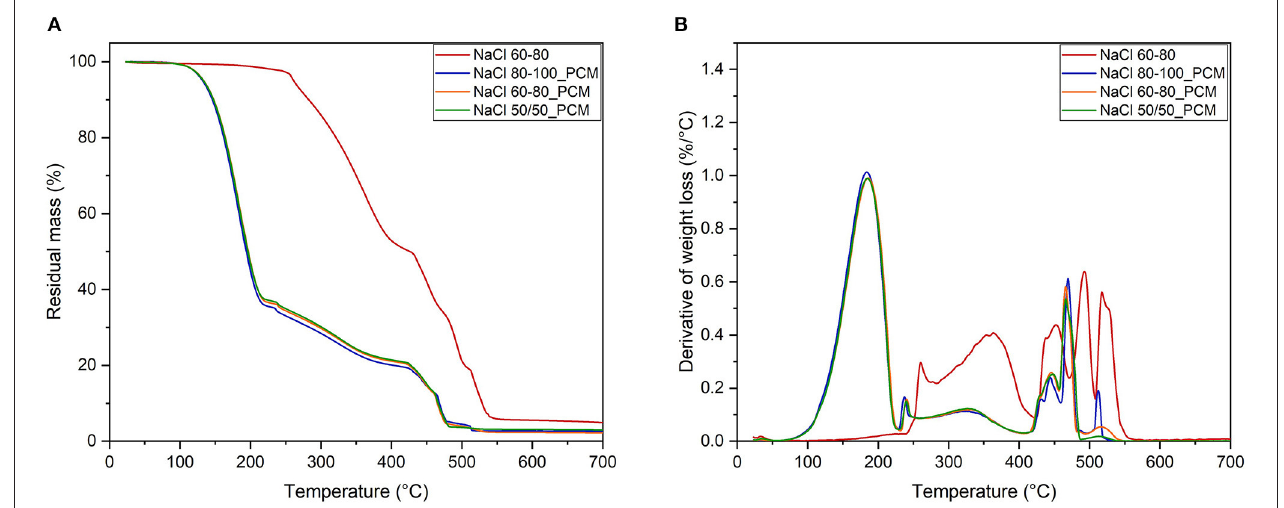
FIGURE 3 | Thermogravimetric analysis (TGA) curves: residual mass (A) and derivative of mass loss (B) .